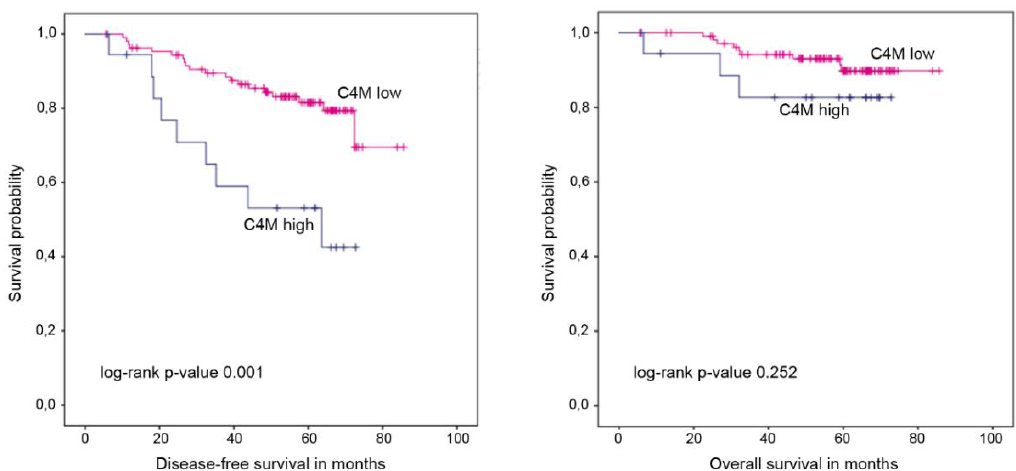
Figure 4. Kaplan–Meier plots of disease-free and overall survival stratified by C4M levels at baseline.